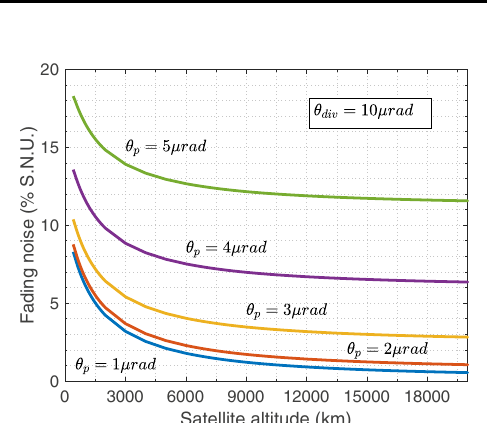
Fig. 5 Fading noise vs. satellite altitude. Trend of the fading excess noise, ξ fad , in percentage of the shot noise units, as a function of the satellite altitude for several values of pointing error and a fi xed value of the divergence